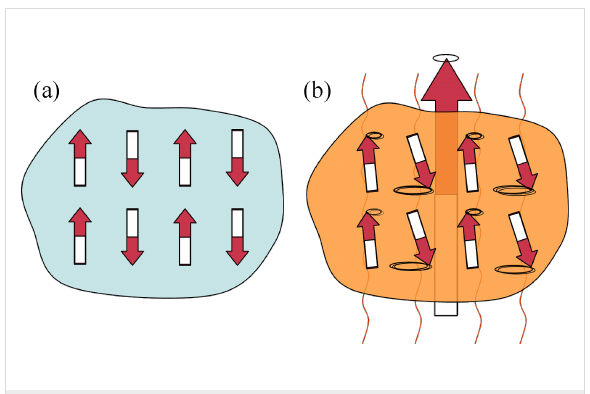
Figure 7: Schematic illustration of the uniform mode in antiferromag- netic nanoparticles: (a) At low temperatures the spins in the two sublat- tices are essentially antiparallel; (b) at higher temperatures the two sublattices are not antiparallel, but precess around an easy axis with different precession angles. This leads to a non-zero magnetic moment of the